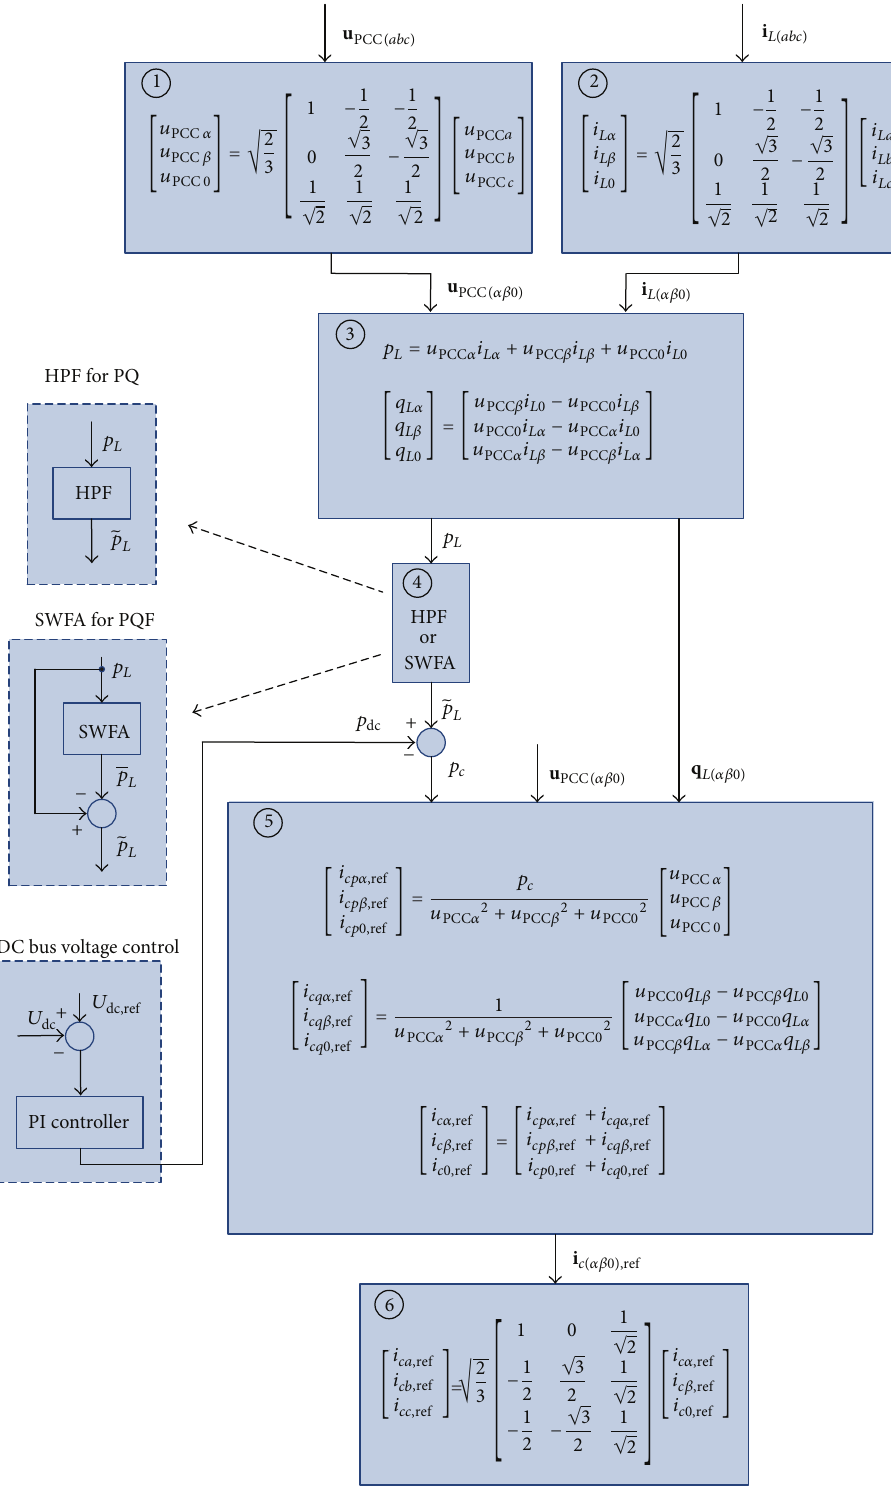
Figure 3: The block diagram of PQ and PQF